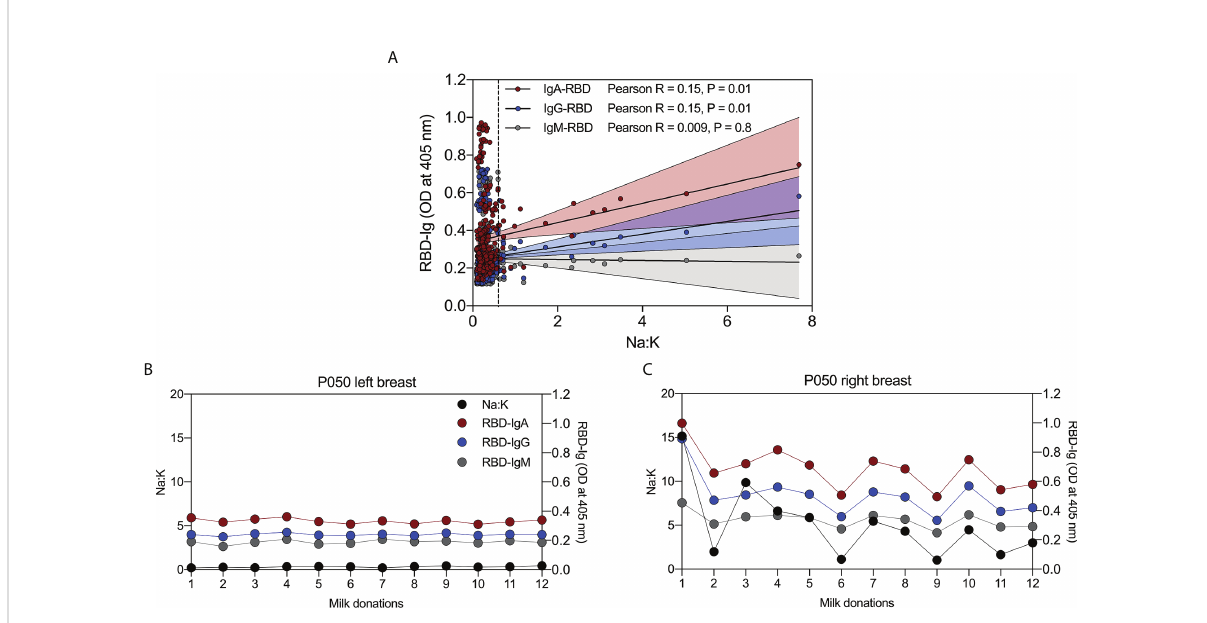
FIGURE 4 Abnormally high permeability of breast epithelium is associated with levels of RBD-reactive antibodies in milk. (A) Weak positive correlation between Na:K and RBD-IgA, and -IgG, and no correlation between Na:K and RBD-IgM in serial milk from 30 women with COVID-19. (B) Relationship between Na:K and RBD-IgA, -IgG, and -IgM in milk from the left breast and (C) right breast from a single woman with COVID- 19. Vertical dashed line in (A) indicates an Na:K =